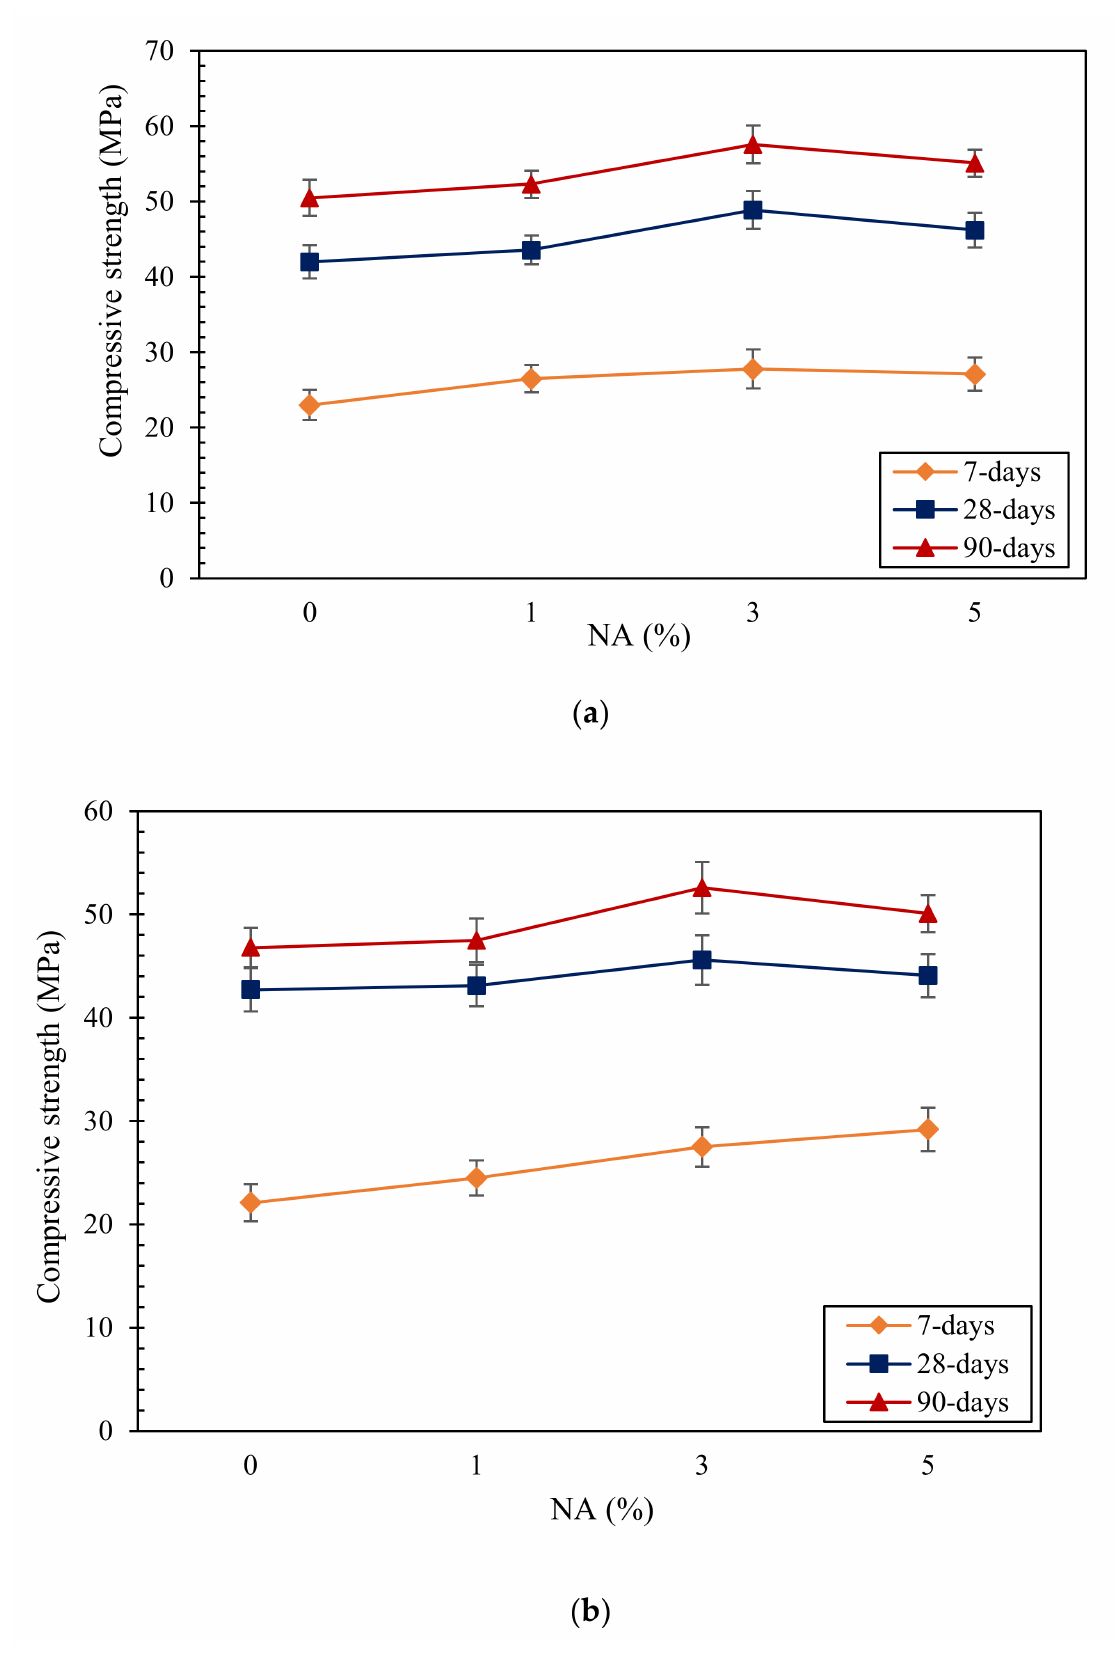
Figure 1. Compressive strength of SC mortars, ( a ) RHA = 0%, ( b ) RHA =